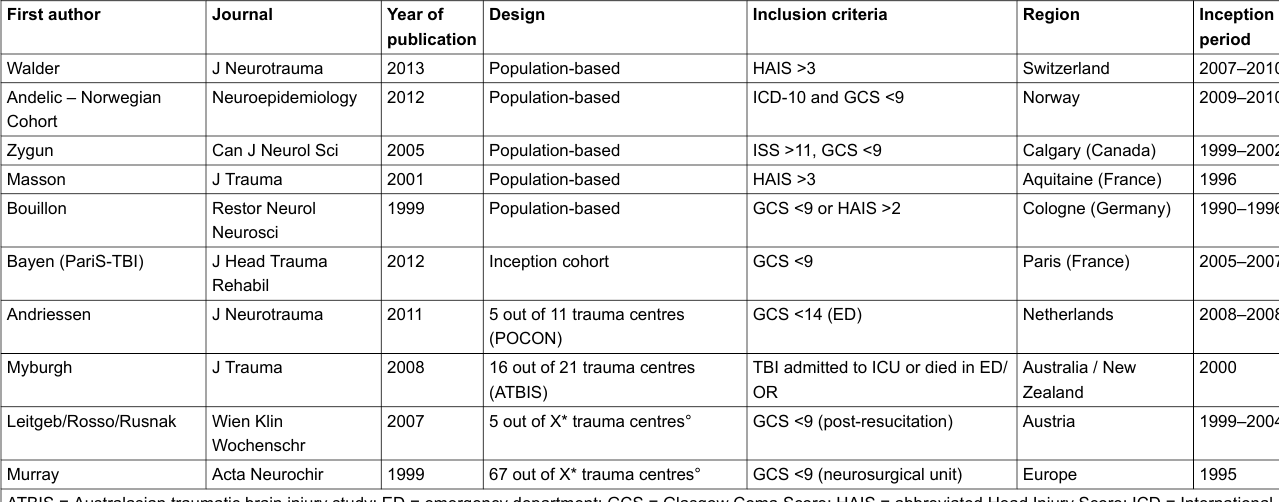
Table 2 : Large, multicentre cohort studies in high-income countries reporting on short-term mortality in adults with severe traumatic brain injury (Part A).